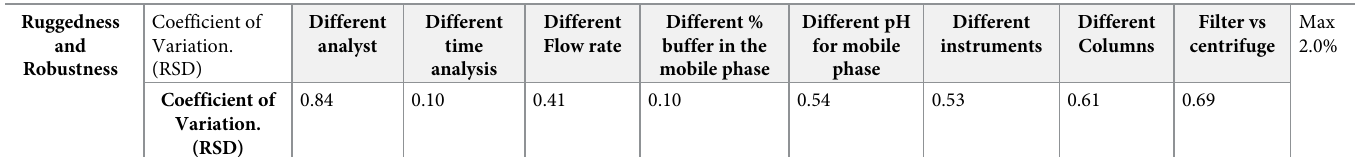
Table 7. Summary ruggedness and robustness results of the assay validation of SiP